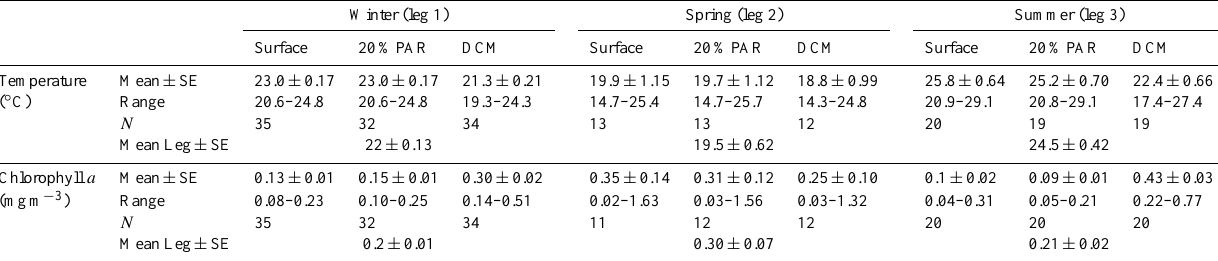
Table 1. Mean ( ± SE) temperature ( ◦ C) and chlorophyll a (mgChl a m − 3 ) for the three sampled depths in Leg 1–winter, Leg 2–spring and Leg